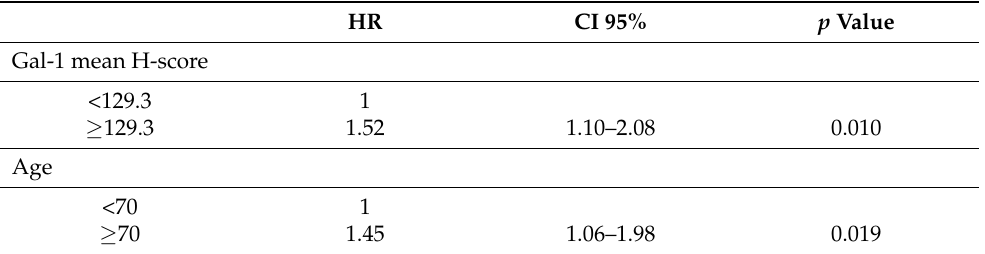
Table 1. Cox regression analyses to identify risk factors for patient survival. Results are shown in terms of hazard ratios (HR), confidence intervals (CI) at 95%, and p values upon Cox regression analyses. HR CI 95% p Value Gal-1 mean H-score